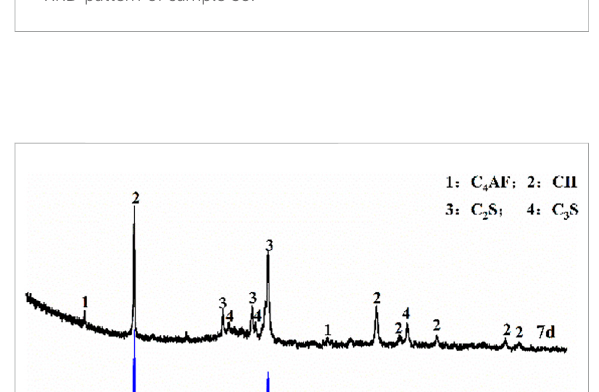
FIGURE 17 XRD pattern of sample S8.